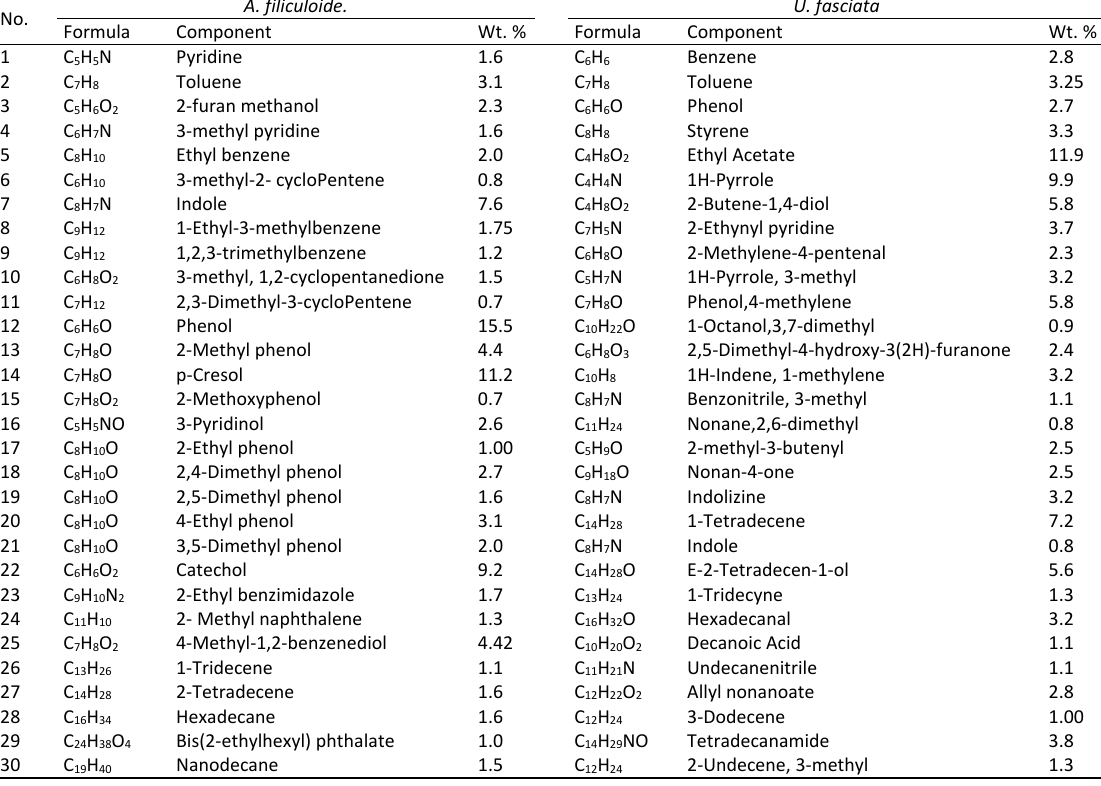
U. fasciata A. filiculoide.